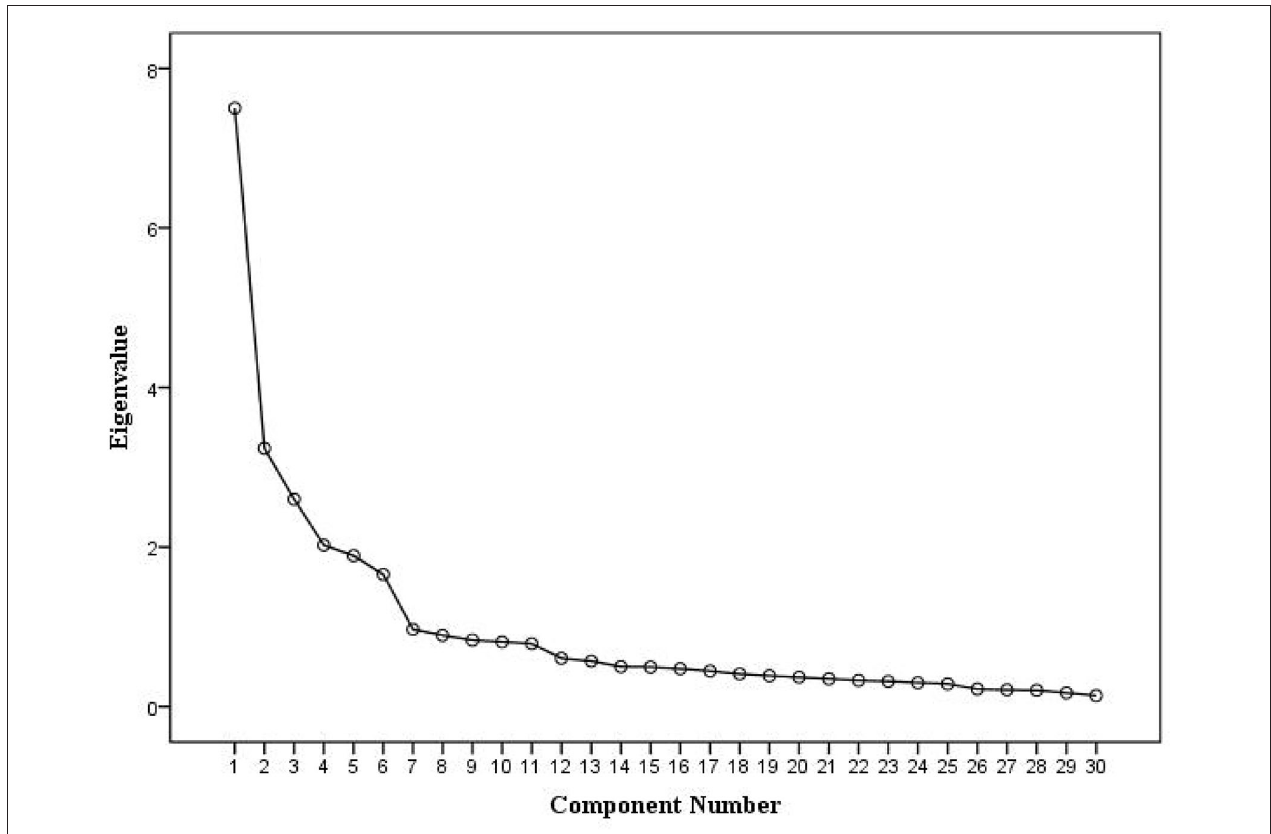
FIGURE 2 | Screen plot of exploratory factor analysis for Chinese version of the occupational low back pain prevention behaviors questionnaire.